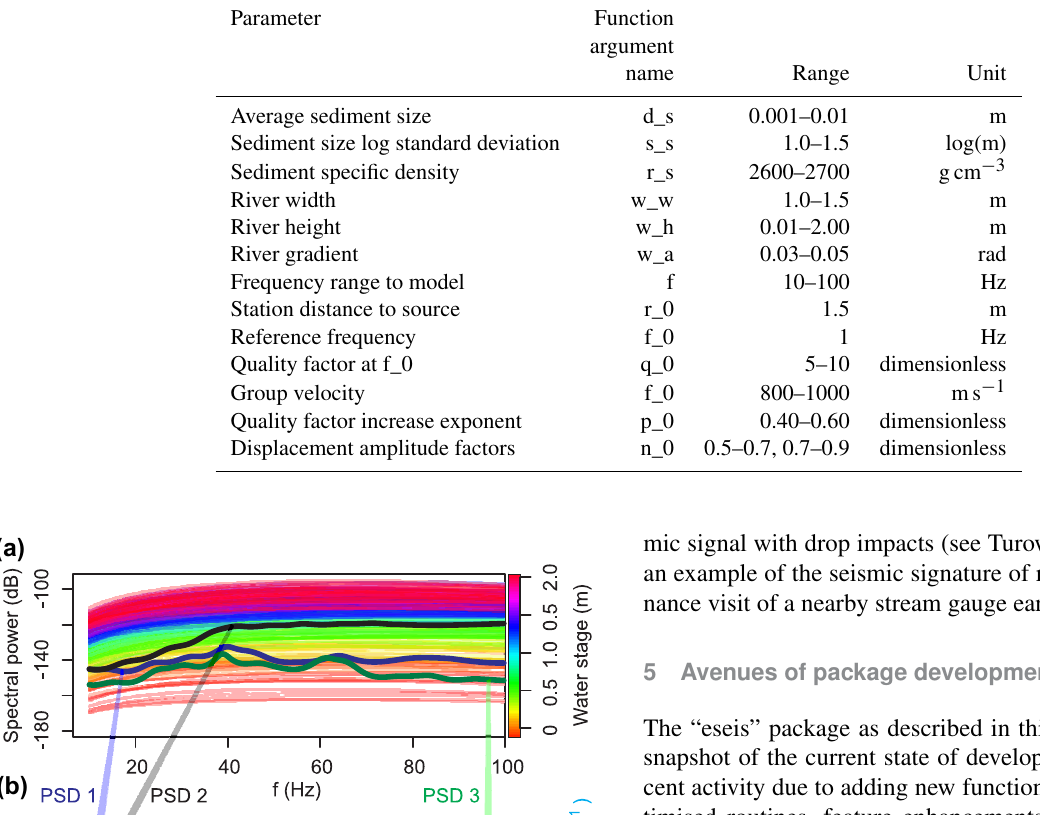
Table 2. Input parameters and value ranges for the turbulence model of Gimbert et al. (2014) as implemented in the “eseis” package.